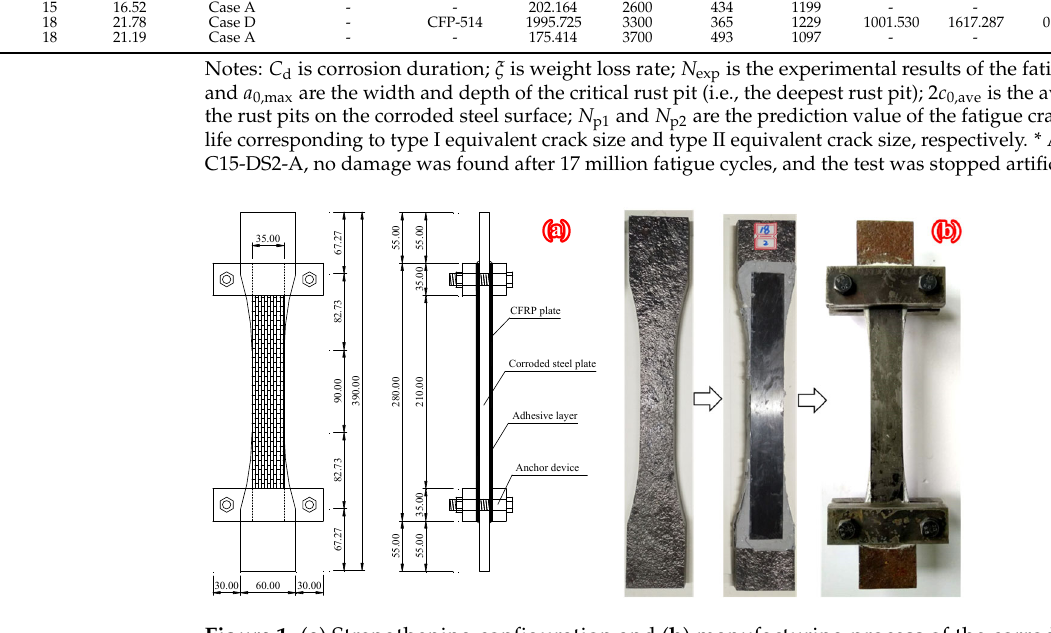
Figure 1. ( a ) Strengthening configuration and ( b ) manufacturing process of the corroded steel plate double-side patched with anchorage.